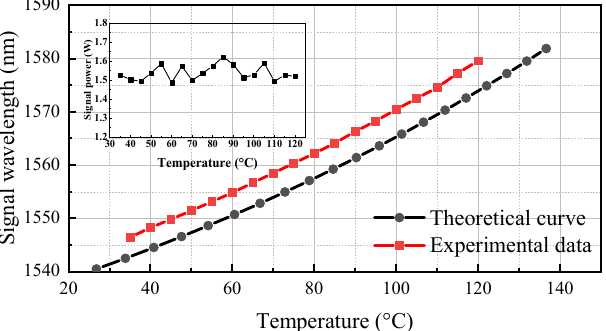
Figure 2. Temperature tuning curves of the signal. Inset: average output power of the signal under an incident pump power of 10 W.